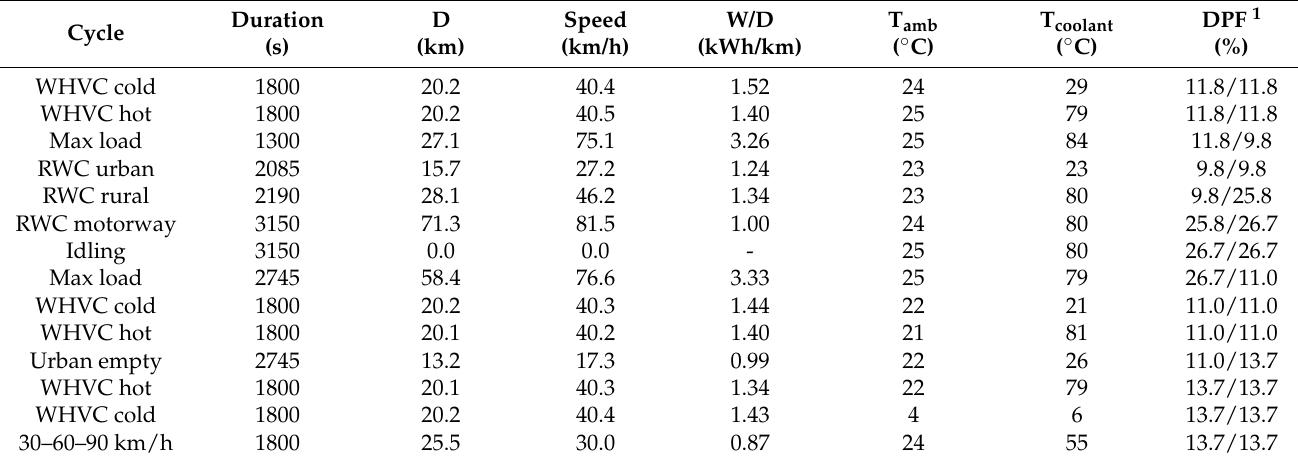
Table 5. Test protocol and main characteristics of the test cycles. All tests with 66% payload except “Urban empty” (9%